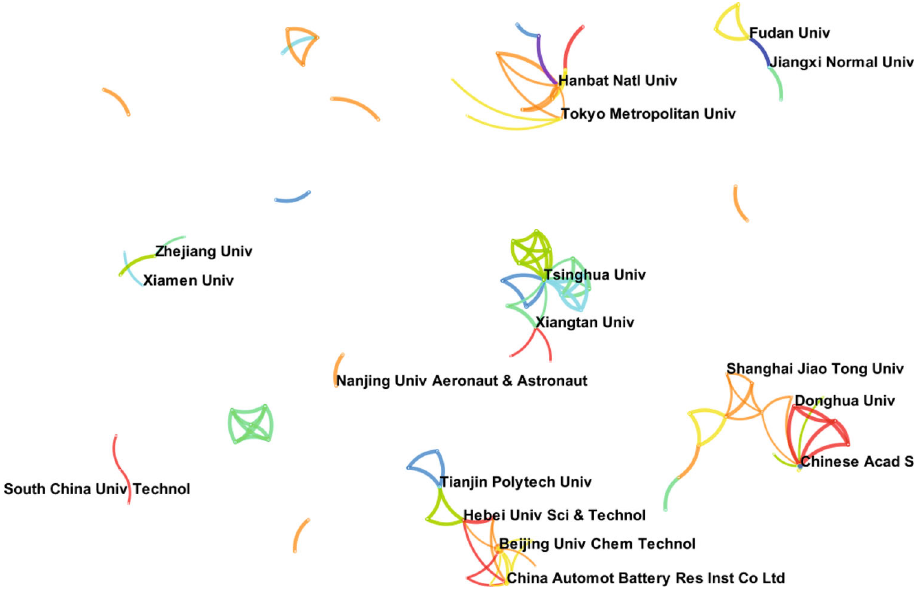
Figure 4: Cooperative network of research institutions.